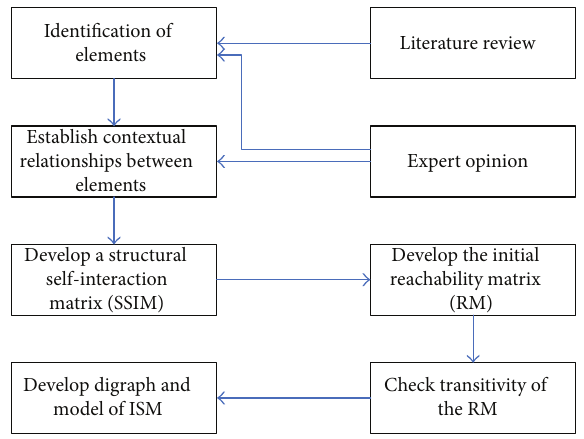
Figure 1: Flow diagram for implementing